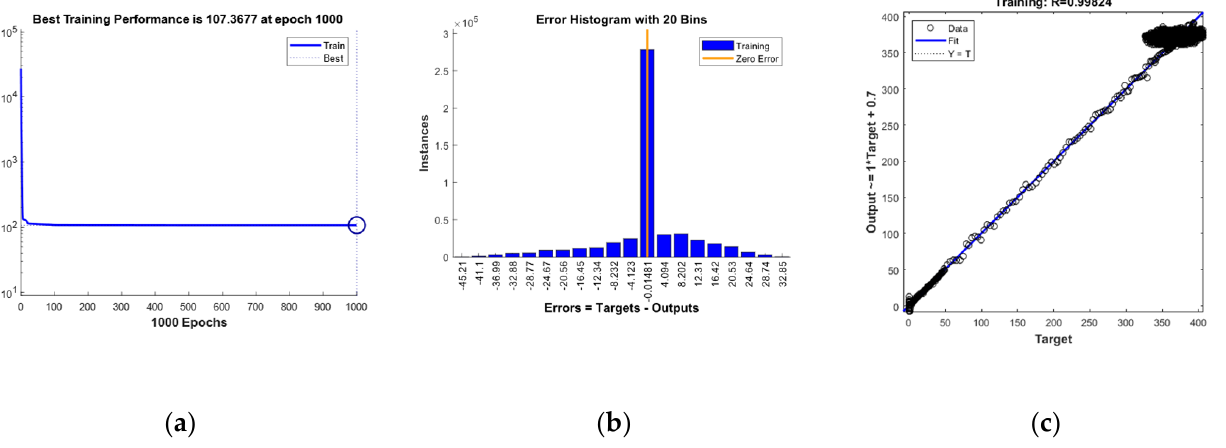
Figure 15. ( a ) Performance of the ANN-based rotor speed estimator considering mean squared error (MSE); ( b ) Error histogram of the ANN-based rotor speed; ( c ) Regression between the rotor speed estimated by the ff ANN and the measured in the IM drive.